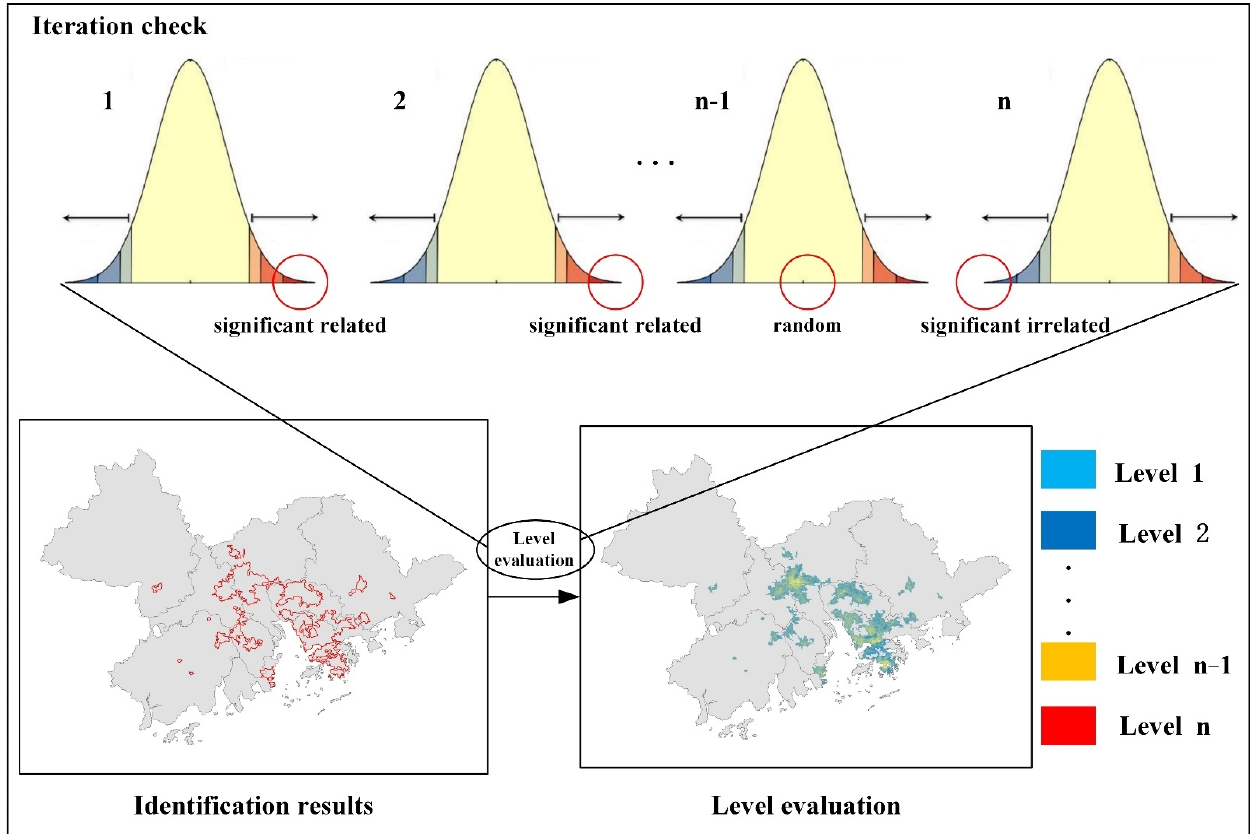
Figure 9. The working flow of the urban poly ‐ center hierarchical level evaluation process.